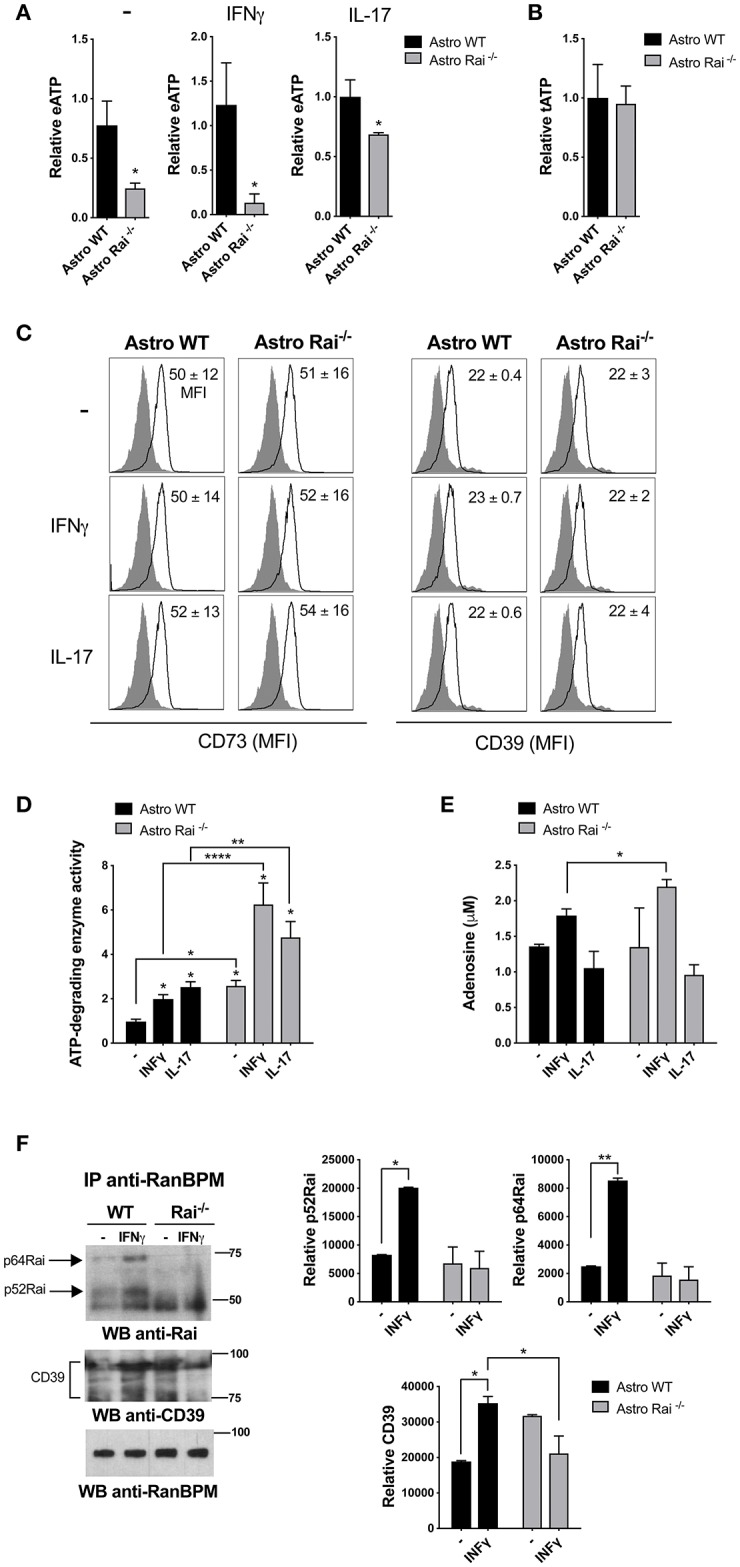
Rai dampens extracellular ATP-degrading enzyme activity in astrocytes. (A) ATP (eATP) quantification in culture supernatants from Rai+/+ (Astro WT) and Rai−/− (Astro Rai−/−) astrocytes stimulated for 5 h with IFNγ (10 ng/ml) or IL-17 (50 ng/ml) or left untreated (-). Data are presented as mean ± SD of relative luciferase units (RLU) in supernatants from Rai−/− astrocytes vs. Rai+/+ astrocytes. Data have been normalized to the mean RLU value of Rai+/+ astrocytes (n = 5). (B) Total ATP (tATP) content in unstimulated Rai+/+ (Astro WT) and Rai−/− (Astro Rai−/−) astrocytes. (C) Flow cytometric analysis of surface CD73 and CD39 in Rai+/+ (Astro WT) and Rai−/− (Astro Rai−/−) astrocytes stimulated for 5 h with IFNγ (10 ng/ml), IL-17 (50 ng/ml) or left untreated (-). Data are presented as mean ± SD of mean fluorescence intensity (MFI) (n = 4). (D) Quantification of enzymatic activities of extracellular ATP-degrading enzymes in Rai+/+ (Astro WT) and Rai−/− (Astro Rai−/−) astrocytes stimulated with IL-17 or IFNγ for 5 h or left untreated (-), then depleted of their culture supernatant and incubated with 1 mM ATP. Data are presented as mean fold change ± SD of specific enzymatic activities (nmol free phosphate/mg protein/min) in Rai+/+ astrocytes and Rai−/− astrocytes, with unstimulated Rai+/+ astrocytes taken as 1 (n = 3). (E) Quantification of adenosine in culture supernatants of astrocytes treated as in D. Data are presented as mean ± SD of adenosine concentration (μM) (n = 3). (F) Immunoblot analysis with anti-Rai or anti-CD39 antibodies of RanBPM-specific immunoprecipitates from total cell lysates of Rai+/+ and Rai−/− astrocytes treated with IFNγ (10 ng/ml) for 15 min (n = 2). The quantification by laser densitometry of the levels of each of the proteins normalized to the level of RanBPM in each sample is shown (n = 2). 2-Way ANOVA and Mann–Whitney test ****p < 0.0001, **p < 0.01, *p < 0.05.